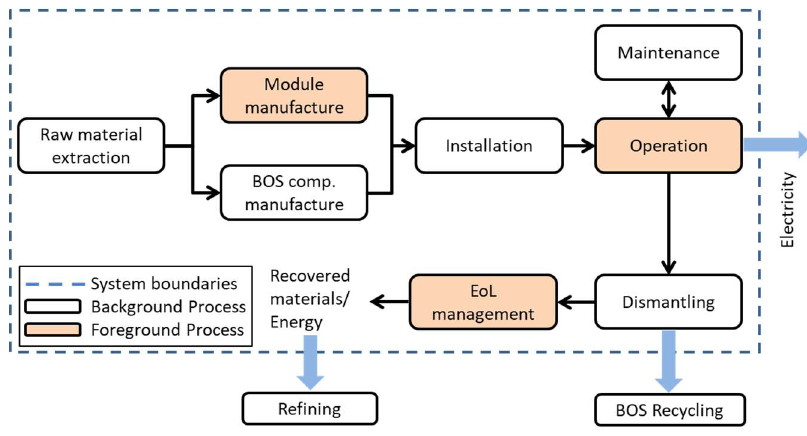
Figure 1. System boundaries of the current study.